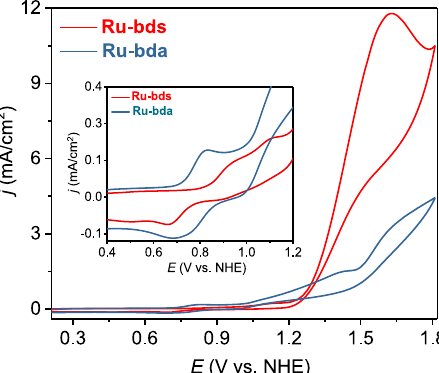
Fig. 8 Electrochemical behavior under neutral conditions. CVs of 1.0 mM Ru-bda and Ru-bds in pH 7.0 phosphate buffer containing 20% volume CH 3 CN with scan rate of 100 mV s − 1 [0.2 M phosphate buffer, I = 0.5 M (NaNO 3 )], the diameter of glassy carbon working electrode is 3 mm. Inset: Enlargement of the 0.4 − 1.2 V zone in the